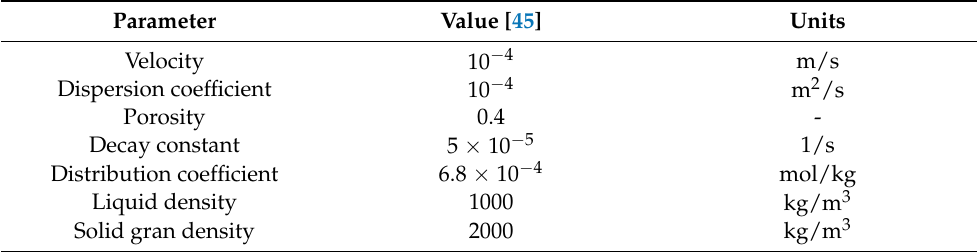
Table 4. Parameter values for simulation in transient advection and